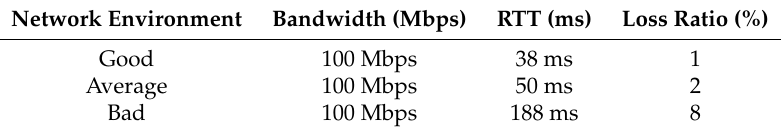
Table 1. Network environments for simple and dumbbell topologies.